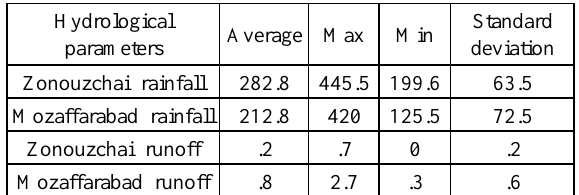
Table 2. Statistical characteristics of annual rainfall and